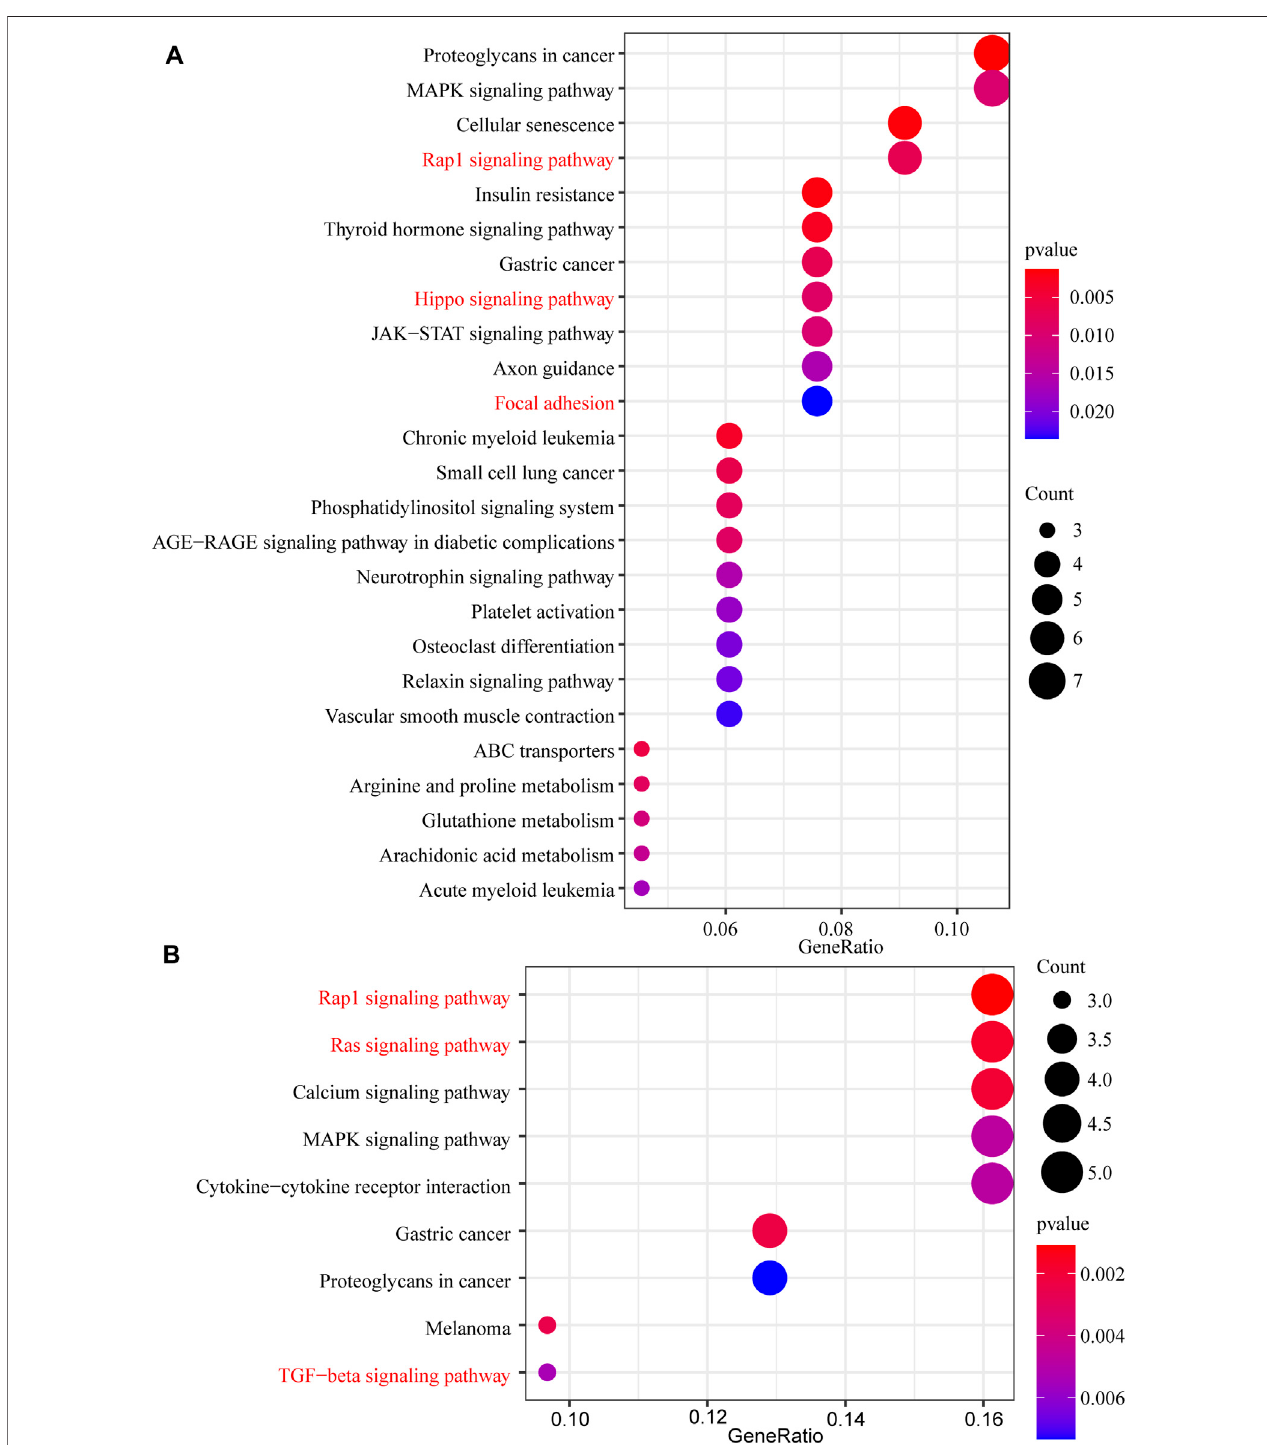
FIGURE 3 | The KEGG pathway enrichment analysis of DEGs (A) The KEGG pathway enrichment analysis of upregulated DEGs (B) The KEGG pathway enrichment analysis of downregulated DEGs.